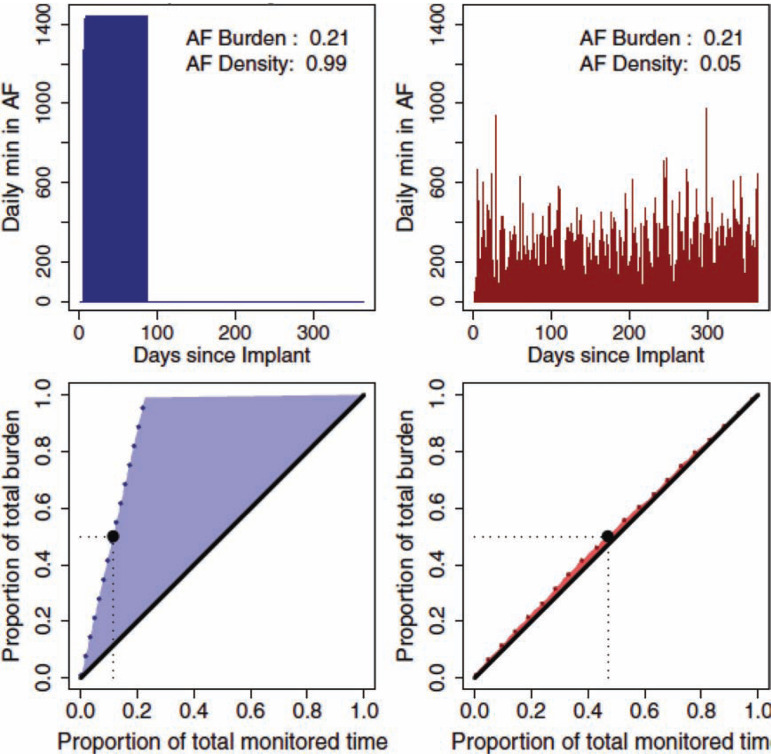
Reconstruction of AF burden and density in two patients with dual-chamber cardiac rhythm management devices.14 Two patients with the same AF burden but different AF densities. The patients on the left and right have high- and low-density AF, respectively. With the rhythm history reconstructed, the course of the minimum monitored time required for each burden proportion is plotted against the proportion of the total burden (dotted line, bottom). The left patient developed 50% of the total burden in 11% of the monitoring period (black dot, bottom left). In contrast, the right patient required 40% of the observation time to develop 50% of their AF burden (black dot, bottom right) as each day contributes less to the total burden because the AF burden is spread out over more days. The black diagonal lines on the bottom figures represent a hypothetical uniform AF burden distribution. The area between the actual (blue or red dotted lines) and uniform hypothetical (solid black diagonal) AF burden development is evaluated as a measure of the temporal aggregation of the AF burden (AF burden density). Abbreviation: AF: atrial fibrillation. Reprinted with permission from: Charitos EI, Stierle U, Ziegler PD, Baldewig M, Robinson DR, Sievers HH, Hanke T. A comprehensive evaluation of rhythm monitoring strategies for the detection of atrial fibrillation recurrence: insights from 647 continuously monitored patients and implications for monitoring after therapeutic interventions. Circulation. 2012;126(7):806−814. http://circ.ahajournals.org/content/126/7/806.